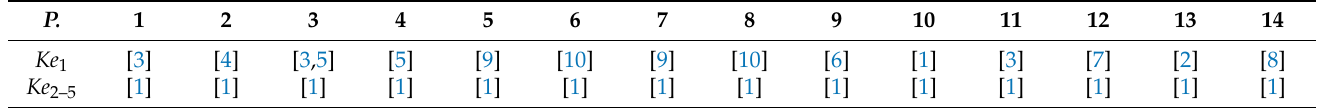
Table 3. Reachability relation between parking spots and